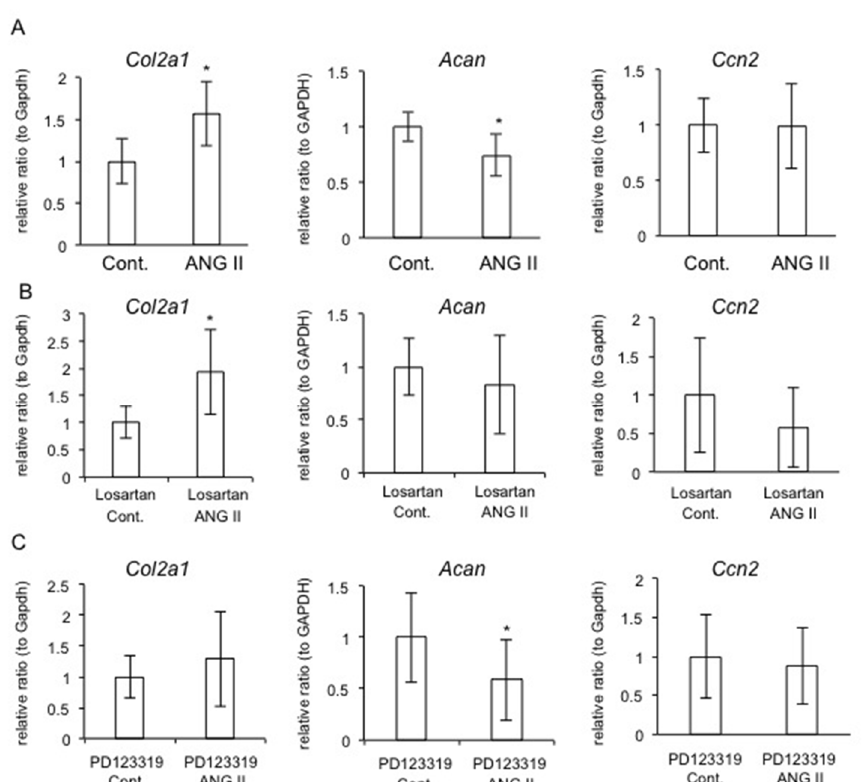
Figure 4. Effect of AT 1 R and AT 2 R blockade on the gene expression of Col2a1 , Acan, and Ccn2 in RCS cells. ( A ) RCS cells were treated with ANG II at 200 nM for 24 h. ( B ) RCS cells were pre-treated with 10 µ M losartan potassium, an AT 1 R antagonist, for 30 min and were stimulated with ANG II at 200 nM for 24 h. ( C ) RCS cells were pre-treated with 10 µ M PD123319, an AT 2 R antagonist, for 30 min and were stimulated with ANG II at 200 nM for 24 h. Quantitative RT-PCR analysis was performed. The amounts of these mRNAs were normalized to the amount of Gapdh mRNA, and the relative ratios with respect to the control (ratio = 1.0) are indicated. The asterisk indicates a significant difference from the control at * p < 0.05.